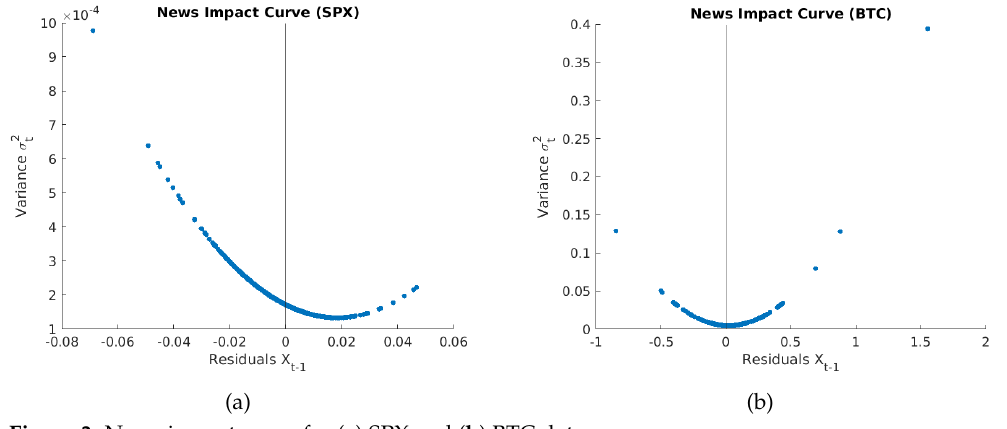
Figure 3. News impact curve for ( a ) SPX and ( b ) BTC